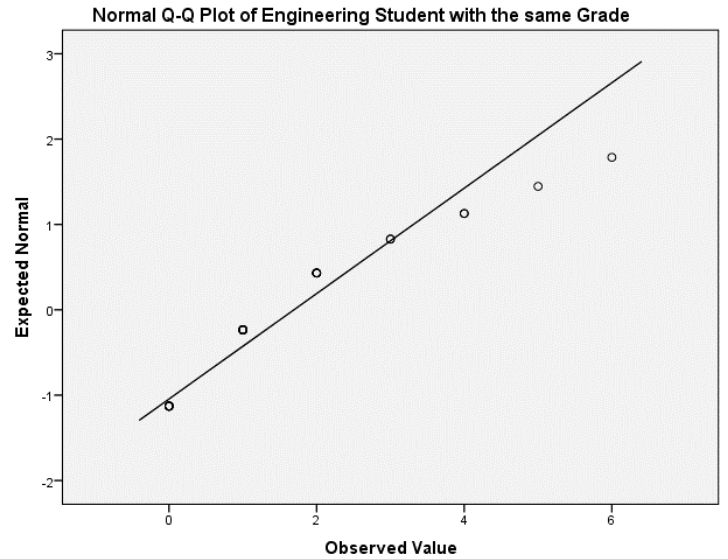
Figure 10. Q-Q plots test for normality assumption